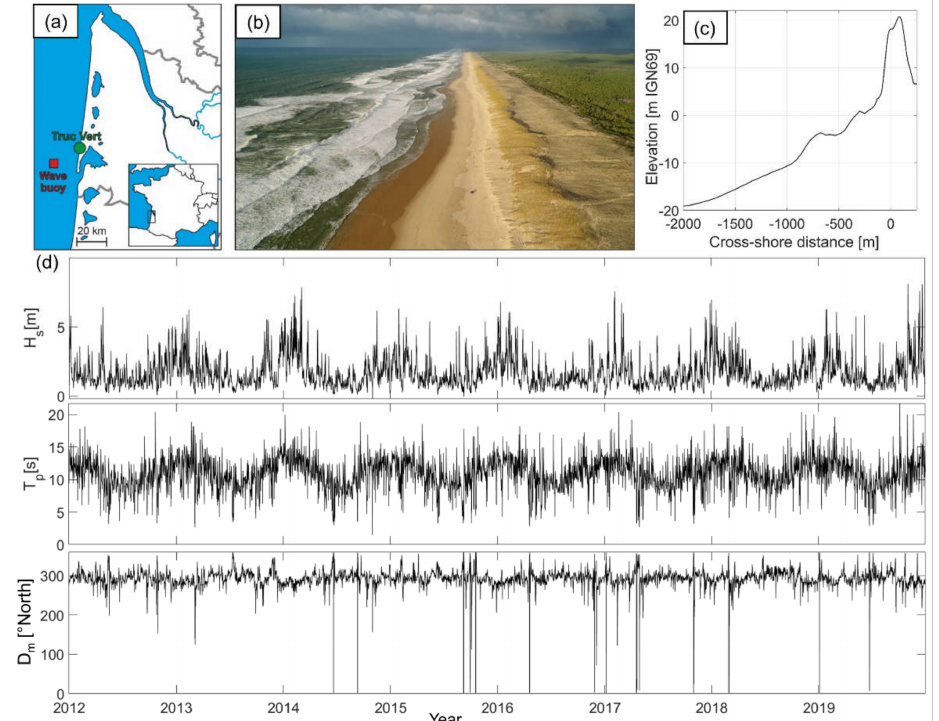
Figure 5. ( a ) Truc Vert beach location (green) and wave data location corresponding to the wave buoy (red); ( b ) photo of Truc Vert beach (photo by V. Marieu); ( c ) alongshore averaged beach profile; ( d ) 2012 to 2019 time series of H s , T p and D m